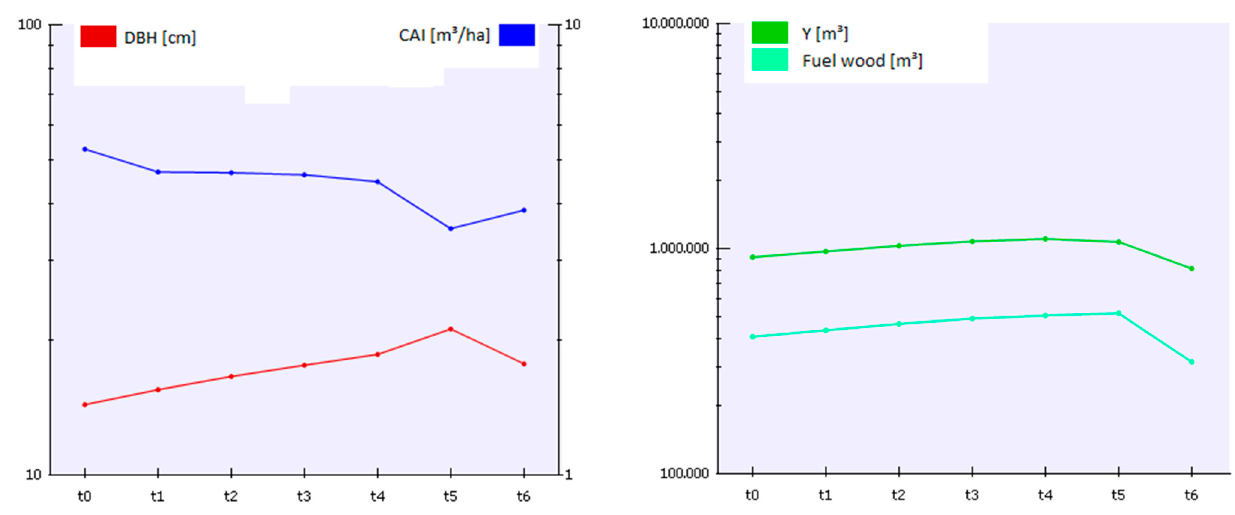
Figure 6. Development of the parameters breast height diameter (DBH [cm], logarithmic scale), current annual increment (CAI (m³/ha), logarithmic scale), yield (Y), and amount